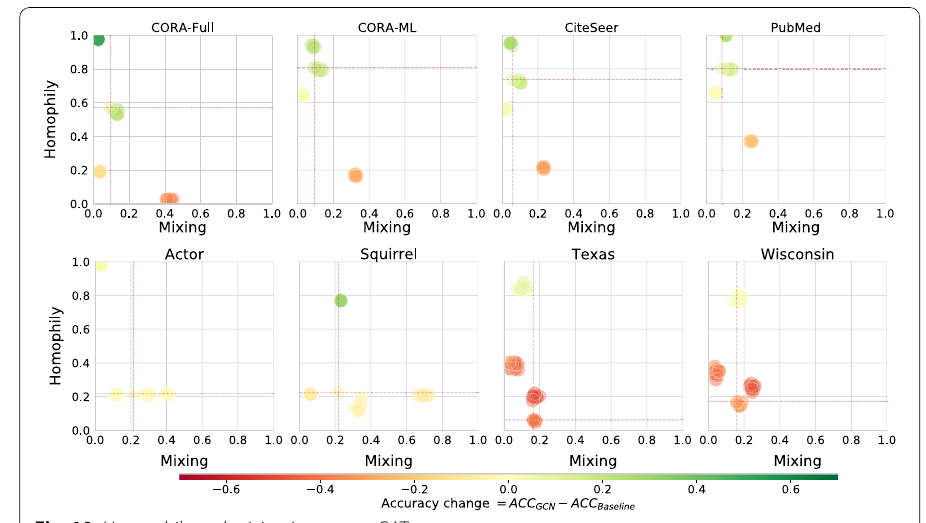
Fig. 10 Homophily and mixing impact on GAT accuracy